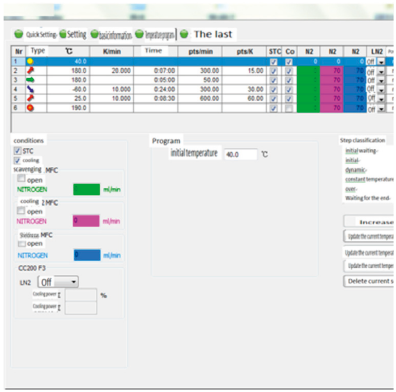
Figure 2: DSC software program interface.